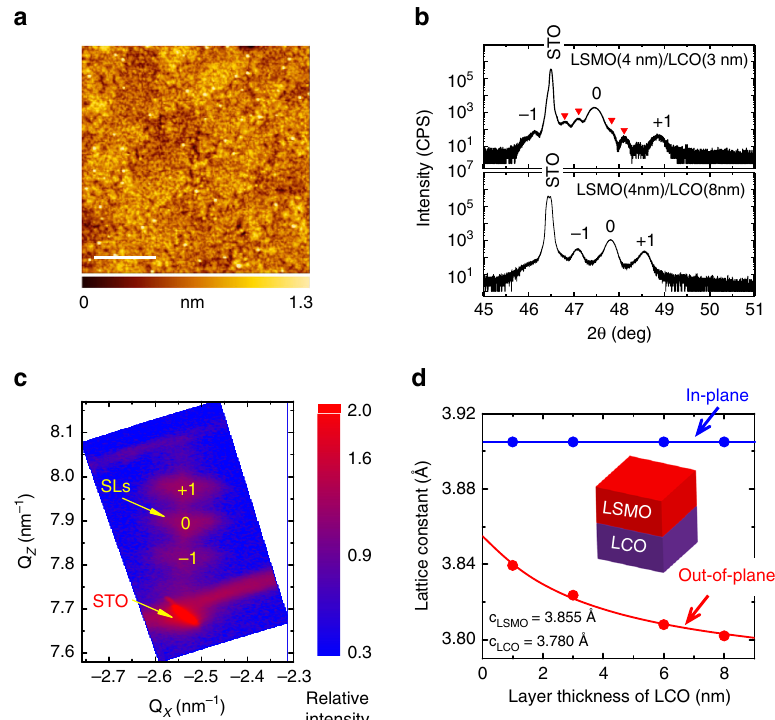
Fig. 2 Structural characterizations of the LSMO/LCO SLs. a Surface morphology of the LSMO(4nm)/LCO(3 nm) SLs. The fi lm is fl at with a root-mean- square roughness of 0.2 nm. Scale bar, 0.5 μ m. b X-ray diffraction patterns of two typical SLs. Satellite peaks corresponding to superstructure (marked by numbers) and interferences due to fi nite fi lm thickness (marked by red triangles) can be clearly seen. c Reciprocal space mapping of the ( − 103) re fl ection of LSMO(4nm)/LCO(8 nm). The vertical alignment for the re fl ections indicates the same in-plane lattice constant of the SLs as substrate. d Lattice parameters of the LSMO(4 nm)/LCO( t LCO ) superlattices as functions of the LCO layer thickness. The deduced c LCO is smaller than the average value of the two A – A distances of the LCO determined by the STEM analysis. Possibly, the brownmillerite phase in the SLs prefers to form in the proximity region of the interface and the LCO layers are not totally of the brownmillerite